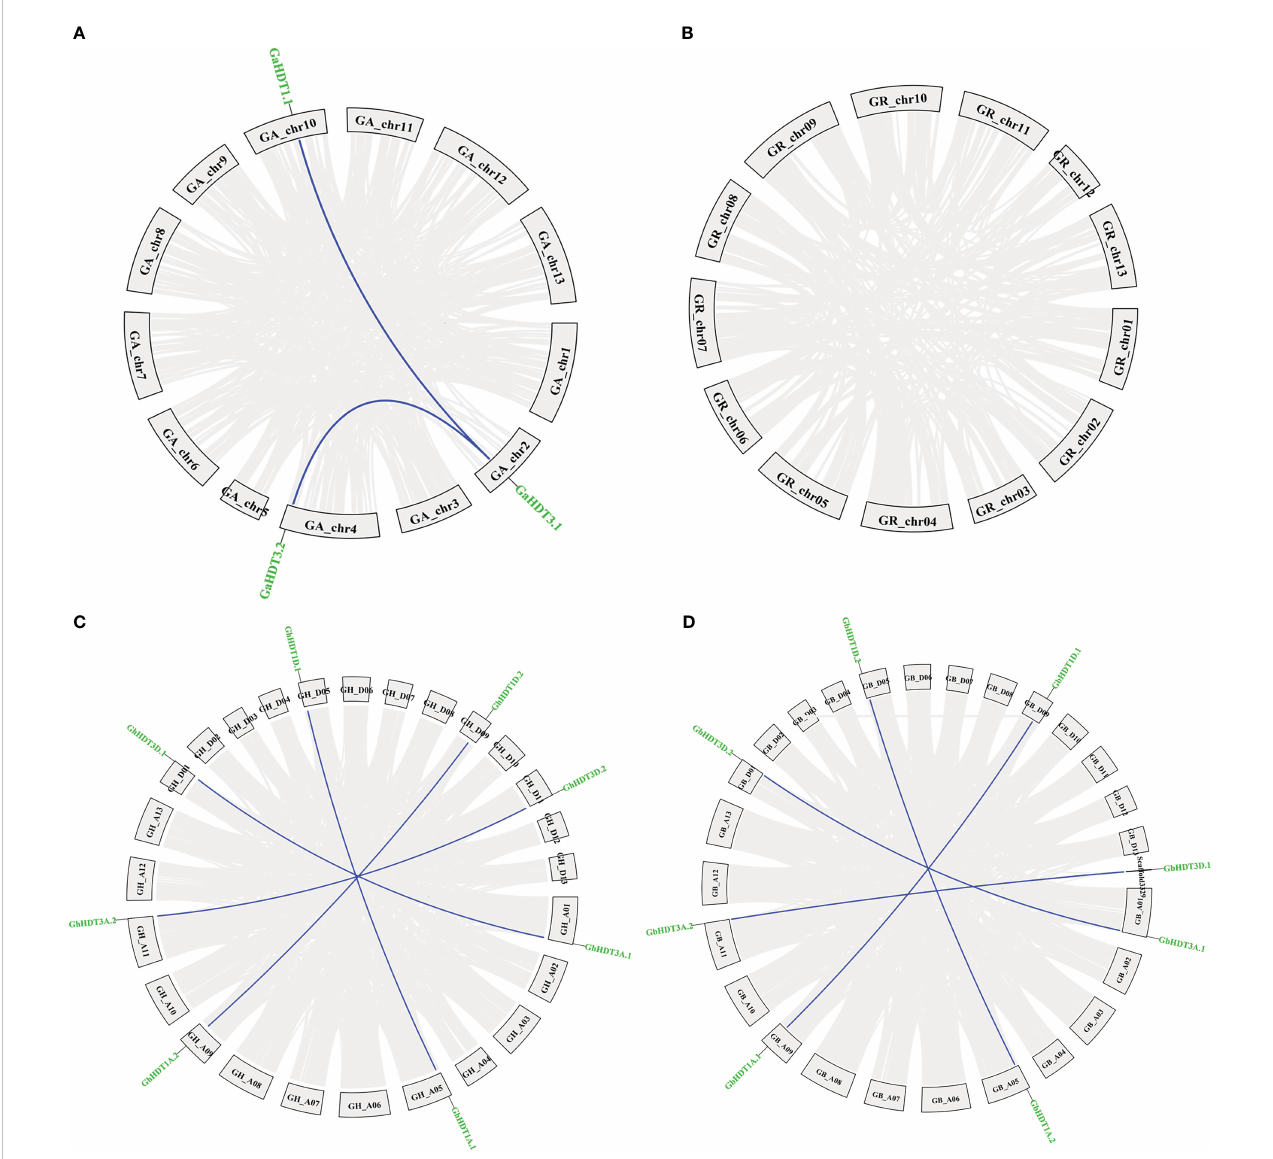
FIGURE 7 Paralogous duplicated HD2 gene pairs in Gossypium genomes ( G. arboreum, (G) raimondii, (G) barbadense , and G. hirsutum) . Depiction of duplicated genes in (A) G. arborium , (B) G. raimondii , (C) G. hirsutum , and (D) G. barbadense . Duplicated HD2 genes are indicated by dark blue lines; collinear blocks are indicated by grey